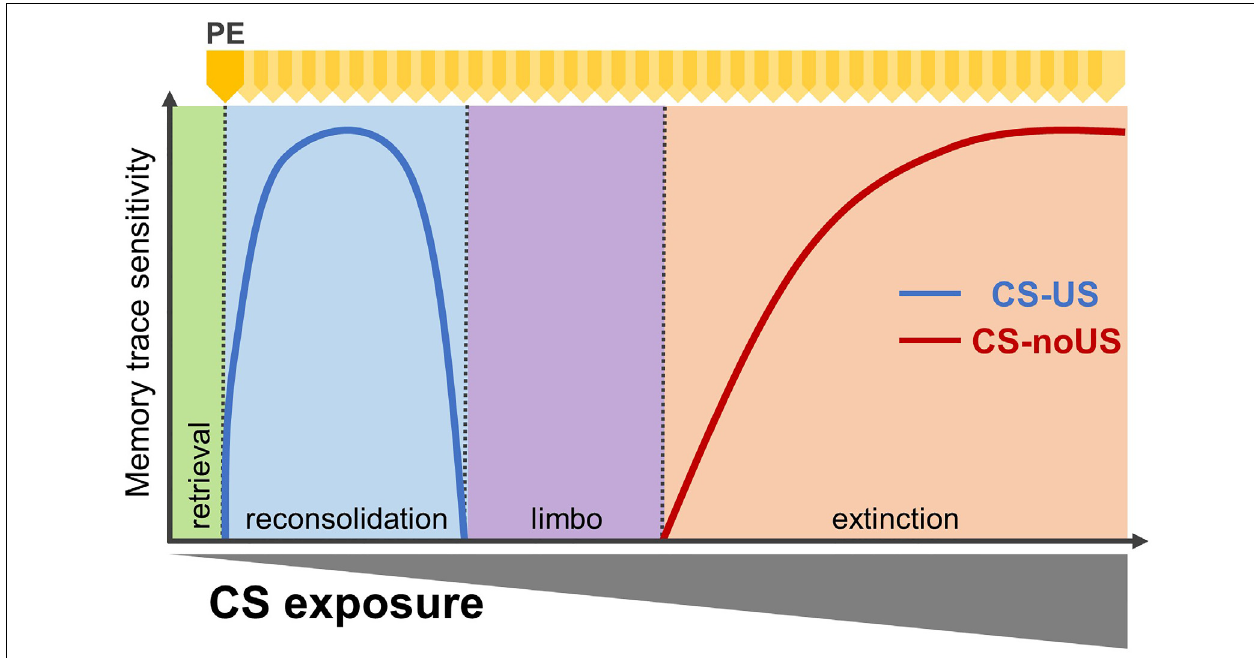
FIGURE 1 | Alternative retrieval-dependent memory processes affecting pavlovian associative memories. Fully consolidated associative memories engage four alternative retrieval-dependent processes, presented in boxes: retrieval alone (green), reconsolidation (destabilisation /re-stabilisation; blue), limbo (purple), or extinction (orange). Prediction error, as the discrepancy between what is predicted by the conditioned stimuli (CS)–unconditioned stimulus (US) memory and what occurs, is necessary for all but retrieval alone. Lines indicate which memory process is dominant depending on CS re-exposure (number of events or duration). Dominant memory traces are those sensitive to amnestic interventions. With a limited number of CS re-exposures, amnestic manipulations reduce subsequent expression of the conditioned response (CR) and are interpreted as engaging memory reconsolidation. By contrast, extended CS re-exposure leads to the formation of extinction memory, and amnestic treatments will prevent this new memory from forming. For intermediate CS re-exposures, neither reconsolidation nor extinction is engaged, and the memory trace becomes insensitive to amnestic agents. PE: prediction error (yellow